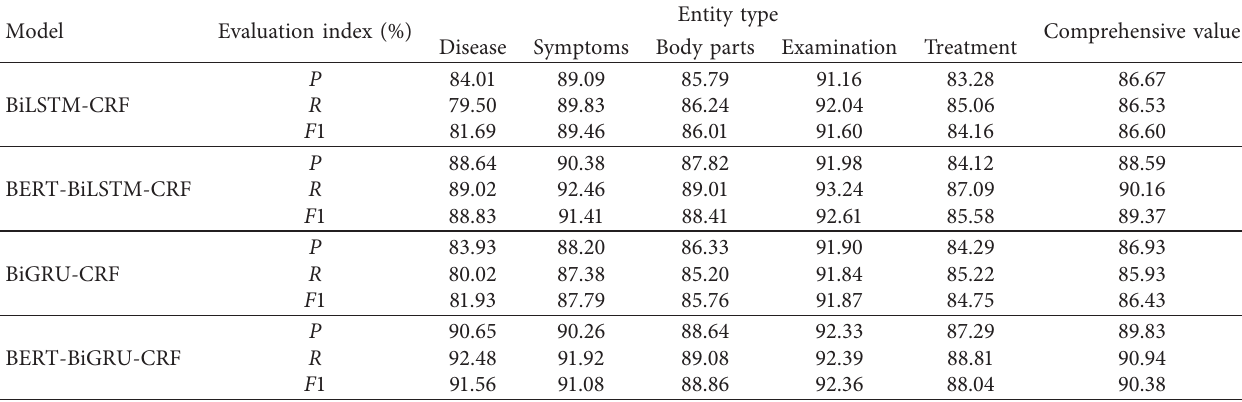
Table 4: Comparison results of each model.